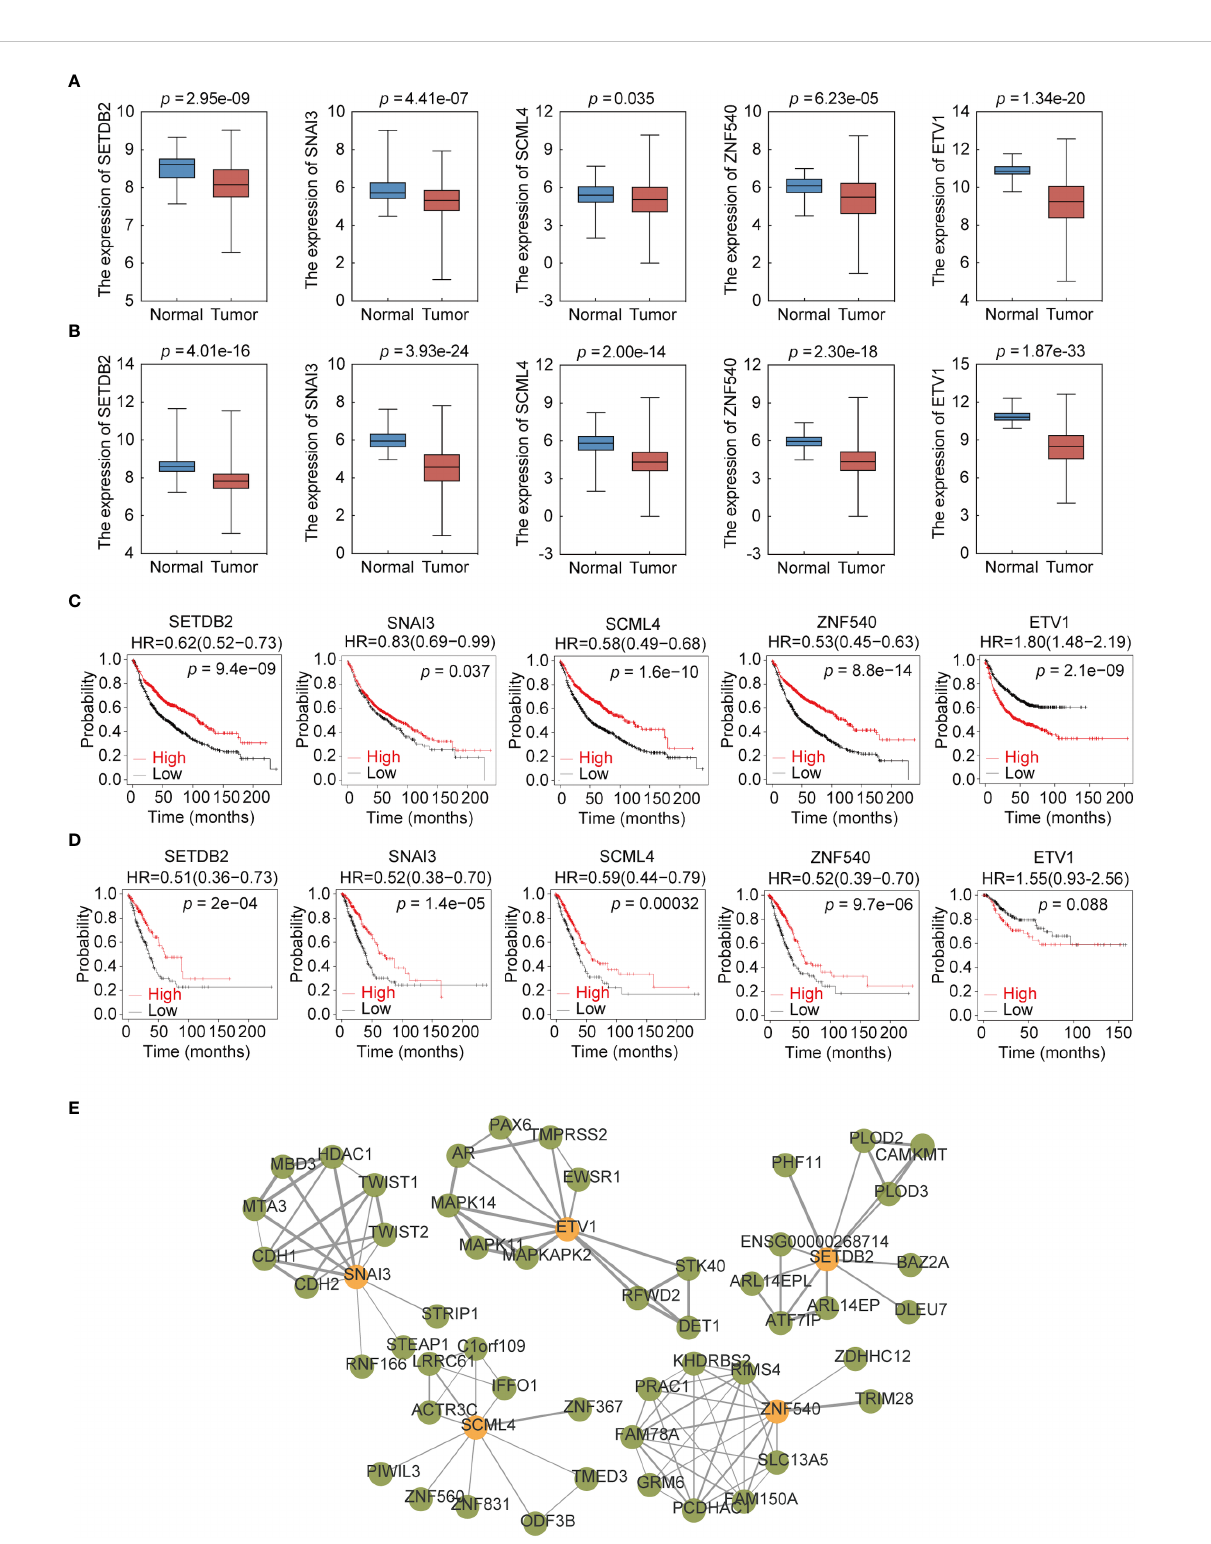
FIGURE 7 Expression pro fi le and survival analysis of 5 transcription factors (TFs) in NSCLC. (A) Expression pro fi le of 5 TFs (SETDB2, SNAI3, SCML4, ZNF540, and ETV1) in LUAD. (B) Expression pro fi le of 5 TFs (SETDB2, SNAI3, SCML4, ZNF540, and ETV1) in LUSC. (C) Kaplan – Meier analysis of 5 TFs (SETDB2, SNAI3, SCML4, ZNF540, and ETV1) using Affymetrix microarray data. (D) Kaplan – Meier analysis of 5 TFs (SETDB2, SNAI3, SCML4, ZNF540, and ETV1) using RNA-seq data. (E) Analysis of the 5-TFs protein interaction